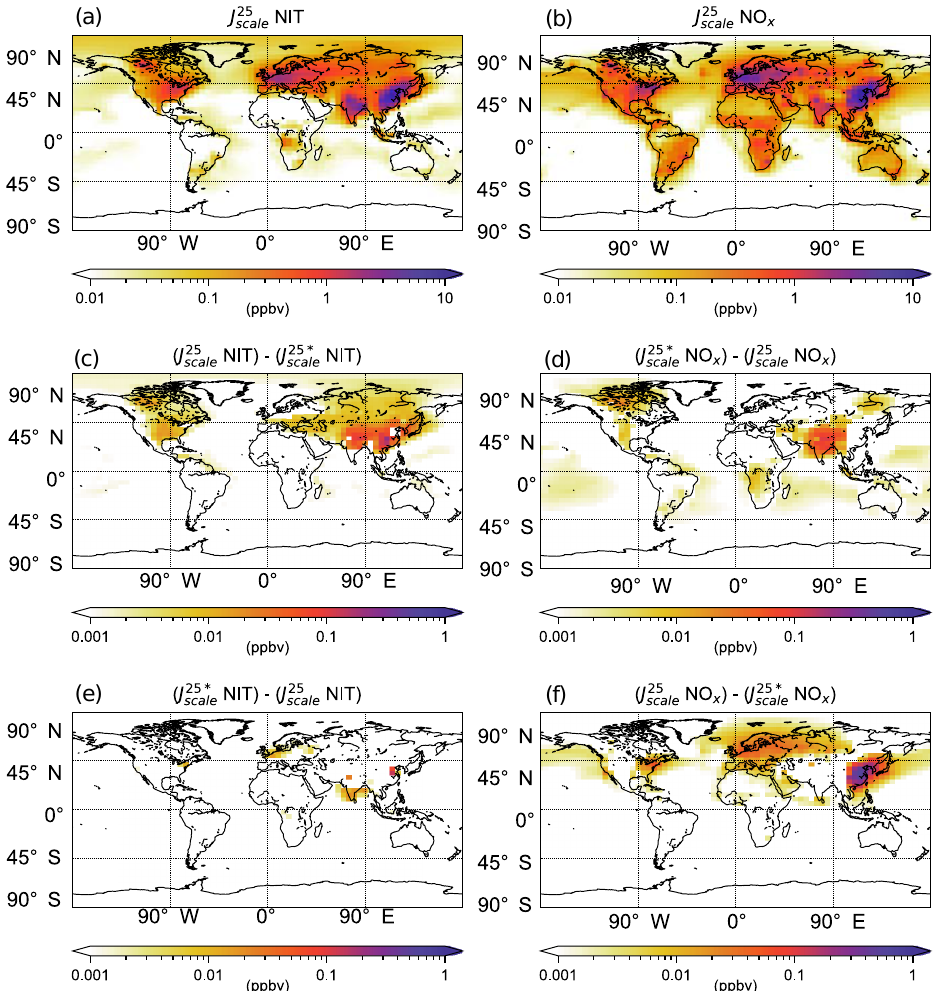
Figure 11. Simulated 2014–2015 boundary-layer-average (average over bottom 1km) accumulation-mode nitrate (NIT) and NO x mixing ratios for the J 25 model (that includes photolysis of only coarse-mode sea-salt nitrate) and the J 25 ∗ scale coarse-mode sea-salt and accumulation-mode NIT) runs. NIT and NO x for the J 25 Panels (c) and (d) show regions where NIT (NO x ) mixing ratios decrease (increase), and panels (e) and (f) show regions where NIT (NO x ) mixing ratios increase (decrease), due to accumulation-mode NIT